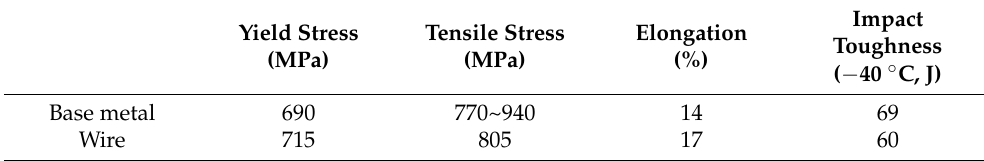
Table 2. Chemical compositions of Q690 plates and the wire.